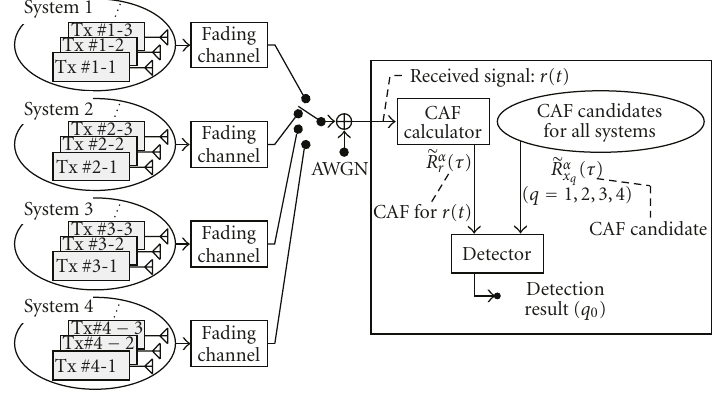
Figure 7: System model.